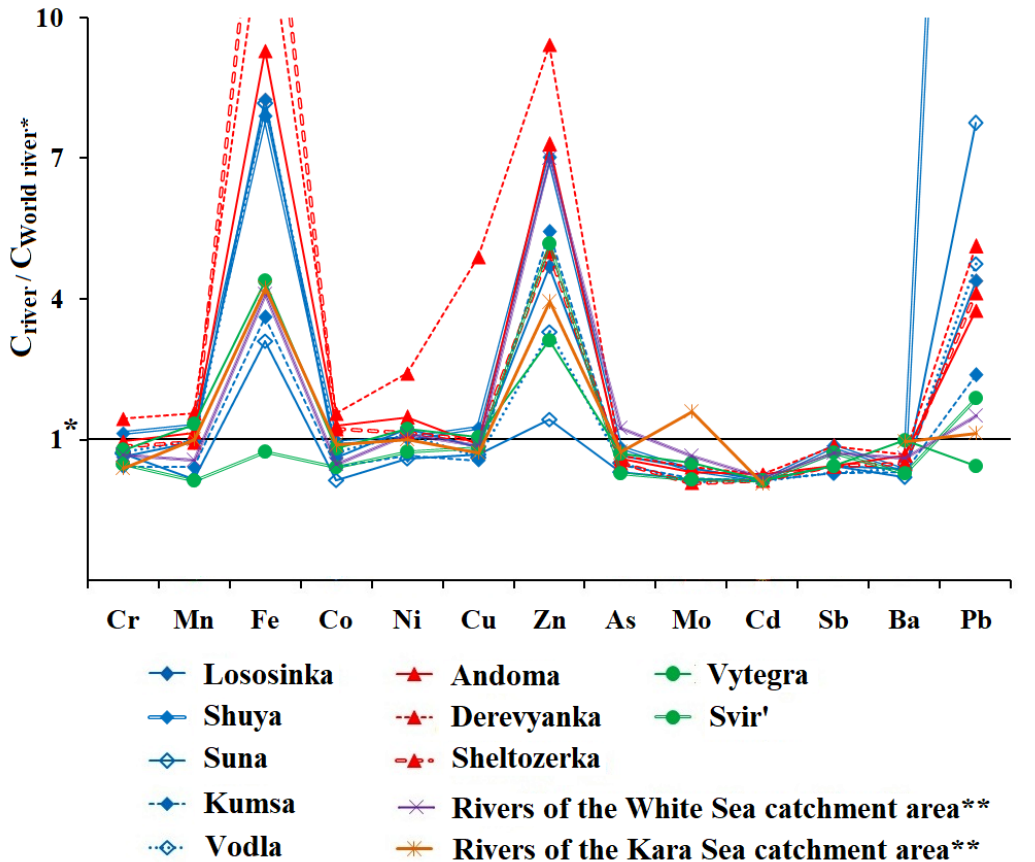
Figure 3. The content of dissolved metals in the waters of the studied rivers in relation to the rivers of the world (*). The arithmetic mean of the elemental content of dissolved metals in the river waters was used for the calculation according to the data in the literature. * [35]; ** [36].